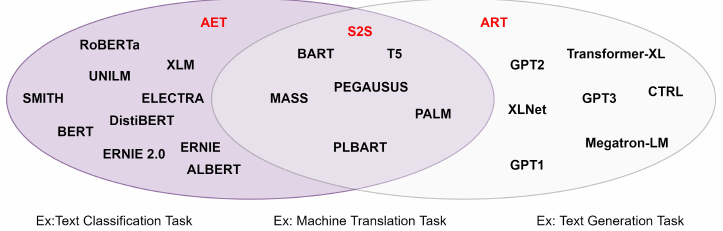
Figure 7. Diagram of the reviewed state-of-the-art TB models and examples of the mostly used downstream